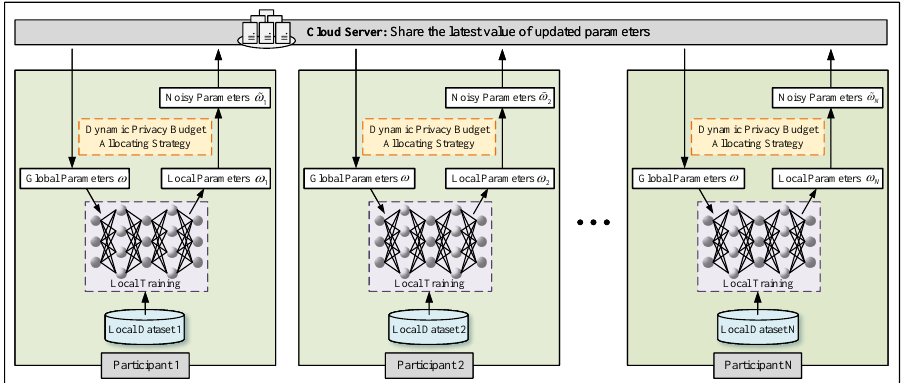
Figure 2. The system architecture of adaptive differentially private multi-party learning